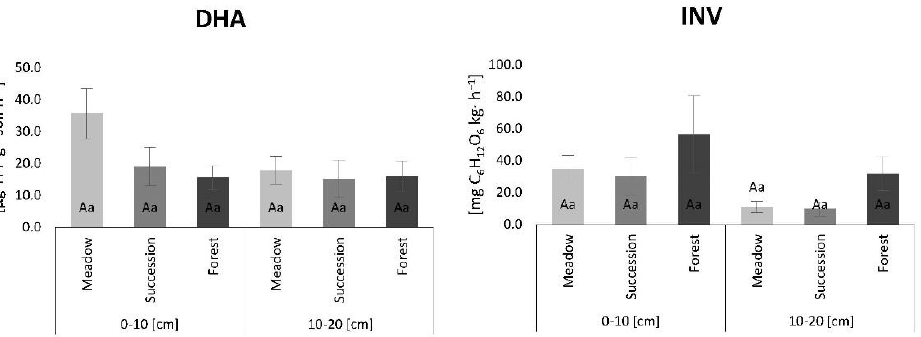
Figure 3. Dehydrogenase activity (DHA) and invertase activity (INV) results. The lowercase letters indicate differences between examined layers for individual land-use variants, while uppercase let- Table 0 and 10 – 20 cm layers (Tukey post hoc test, p < 0.05). Standard error is reported as bars. The mean microbial respiration ranged from 0.09 mg CO 2 g soil −1 24 h −1 (FS, 0 – 10 cm, 5th week) to 1.57 mg CO 2 g soil −1 24 h −1 (MS, 0 – 10 cm, 1st week). Overall, the microbial